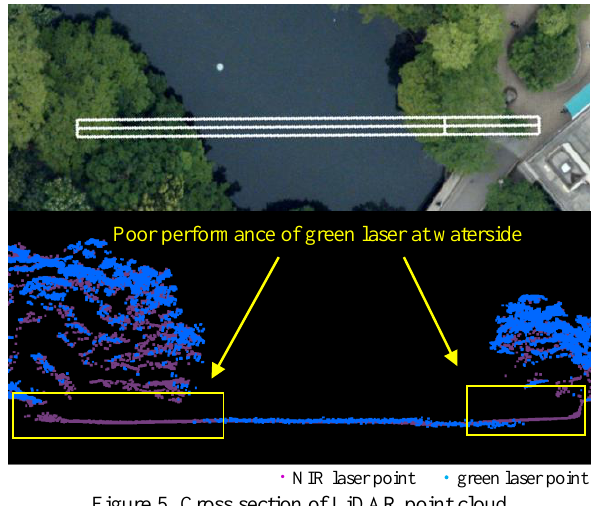
Figure 5. Cross section of LiDAR point cloud *water surface and noise in the water of green laser point cloud were removed.